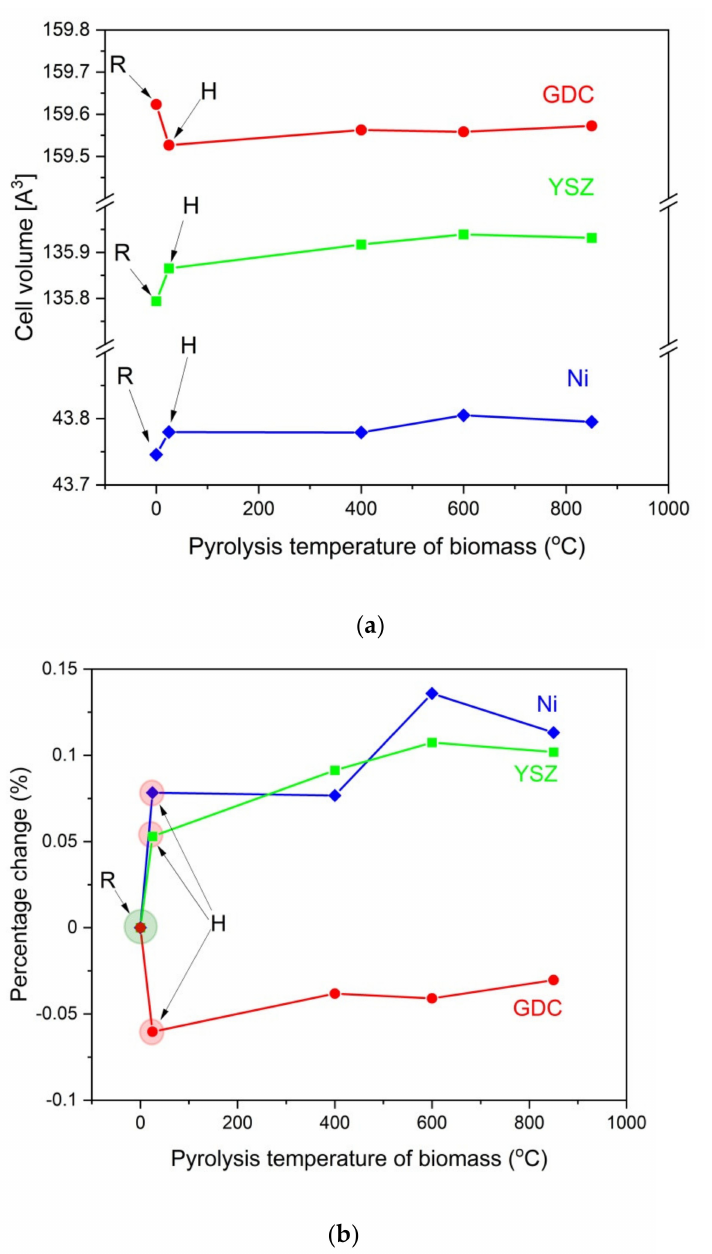
Figure 14. ( a ) Variation in calculated cell volume between base YSZ, GDC, and Ni samples (R) and after heating samples at 850 ◦ C for 100 h without contact with solid carbon fuels (H) and after heating following mixtures: YSZ and solid fuels; GDC and solid fuels, and Ni and solid fuels. ( b ) Variation of percentage changes in cell volume for base YSZ, GDC, and Ni samples (R) after heating samples at 850 ◦ C for 100 h without contact with solid fuels (H) and after heating following biomass mixtures: YSZ and solid fuels; GDC and solid fuels; and Ni and solid